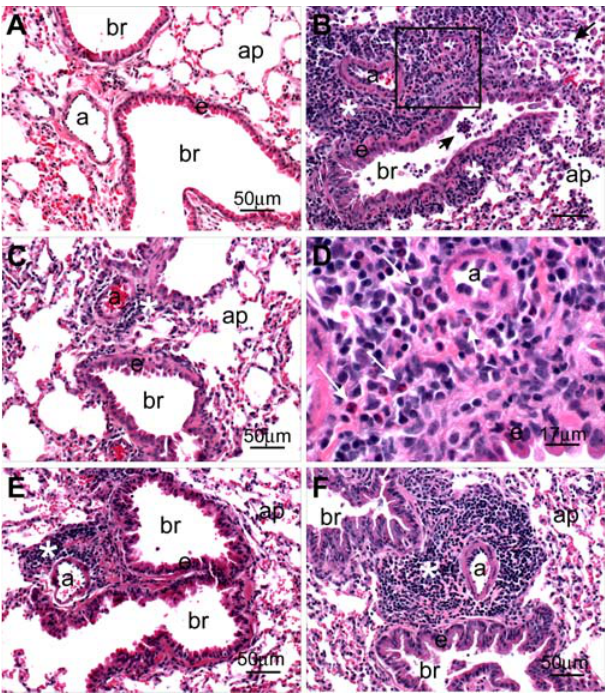
Figure 7. Pathogenic Findings Following Homologous Challenge Light photomicrographs of representative histologic lung sections (Table 1, experiment 2) taken from an untreated control mouse (A), a VRP-N– vaccinated mouse (B) and (D), a VRP-HA–vaccinated mouse (C), a VRP-S– vaccinated mouse (E), and a VRP-S– and VRP-N–treated mouse (F). No histopathology was evident in (A). A marked mixed inflammatory infiltrate composed mainly of mononuclear leukocytes (lymphocytes and plasma cells) and widely scattered eosinophils are evident in the perivascular and peribronchiolar interstitium (asterisk) in (B). Similar inflammatory cells are also present in bronchiolar (br) airways and alveolar airspaces along with enlarged and vacuolated alveolar macro- phages (arrows). The box in (B) denotes the site of the light photomicrograph (D) that was taken at a higher magnification to better illustrate the lymphoplasmacytic inflammatory cell infiltrate with lesser numbers of eosinophils (arrows). Similar, but slightly less severe, perivascular inflammatory infiltrates (asterisk) are also present in (F), but without accompanying alveolitis. Minimal lymphoplasmacytic cell accumulations around the pulmonary arteriole (a) are evident in (C) and (E). All tissues were stained with hematoxylin and eosin. Bars denote the scale of the magnification. a, pulmonary arteriole; ap, alveolar parenchyma; br, bronchiolar lumen; e, surface epithelium of